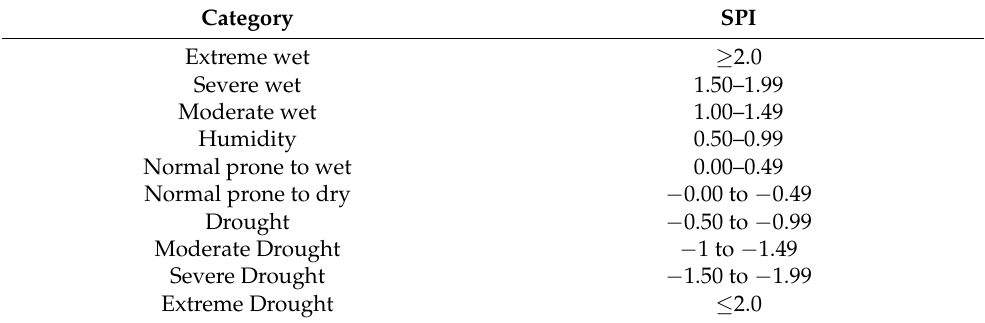
Table 1. Standardized precipitation index (SPI) adapted from McKee et al. [29] and Chan Keb et al.